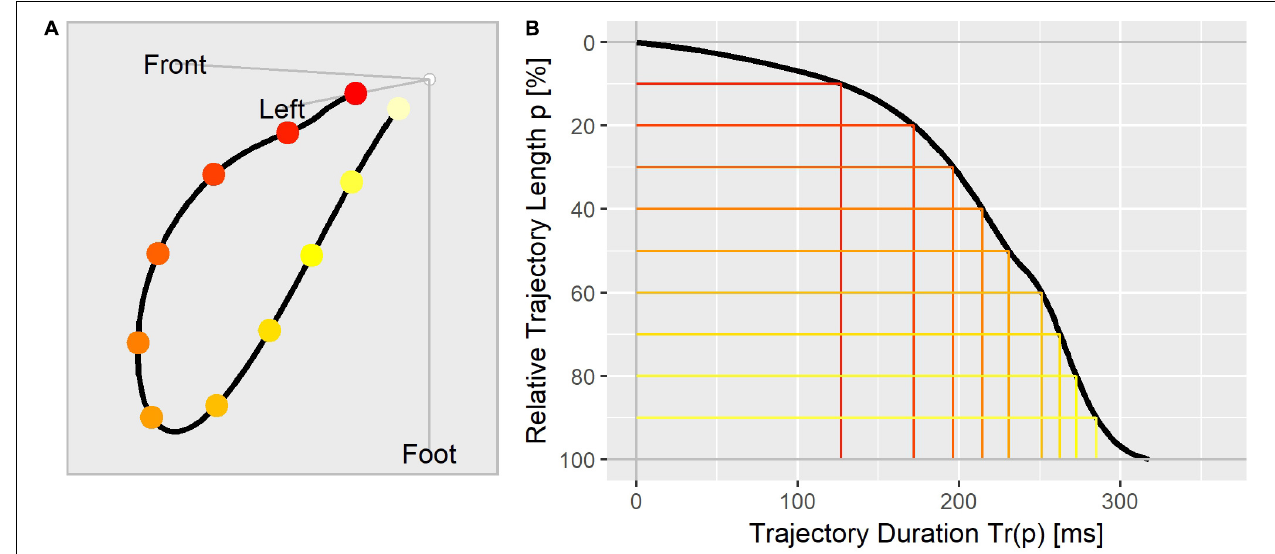
FIGURE 1 | (A) The T vector trajectory displayed in the body’s physical orientation, divided into 10 equally long segments and colored from red (J-point) to yellow (T end ). (B) T vector trajectory duration curve indicating the elapsed time Tr(p) (x-axis) at which the corresponding percentage of the trajectory length (y-axis) is reached. The colored lines correspond to the trajectory points as marked in (A) .